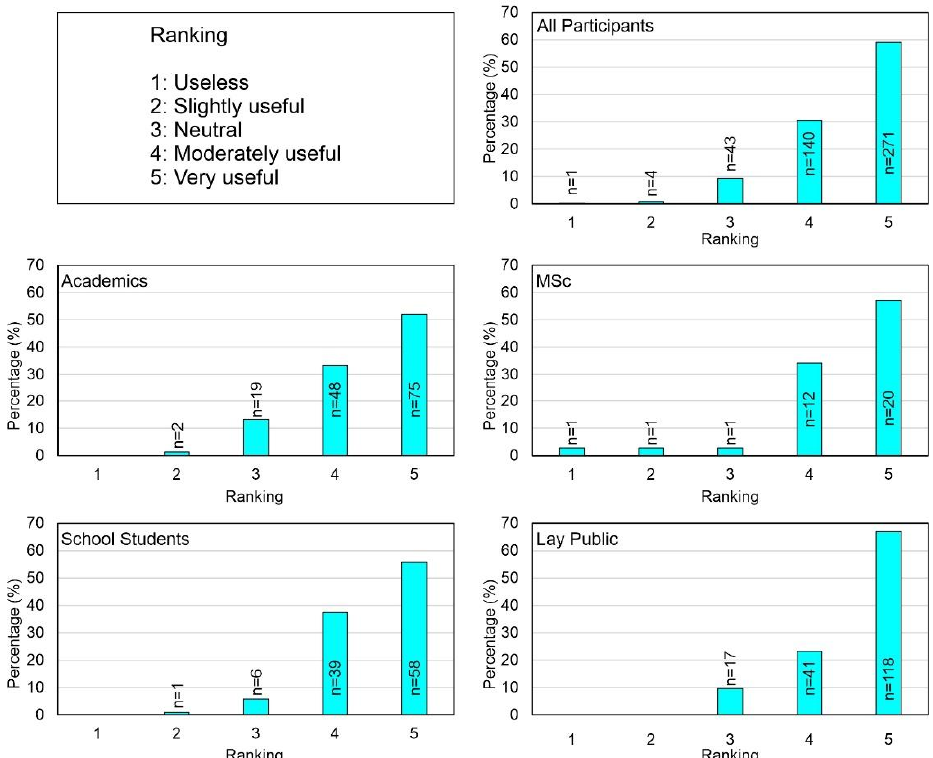
Figure 14. Bar charts showing the possible efficiency of immersive virtual reality as a learning tool in Earth Sciences. The results represent both the total number of participants and the background of each group respectively.